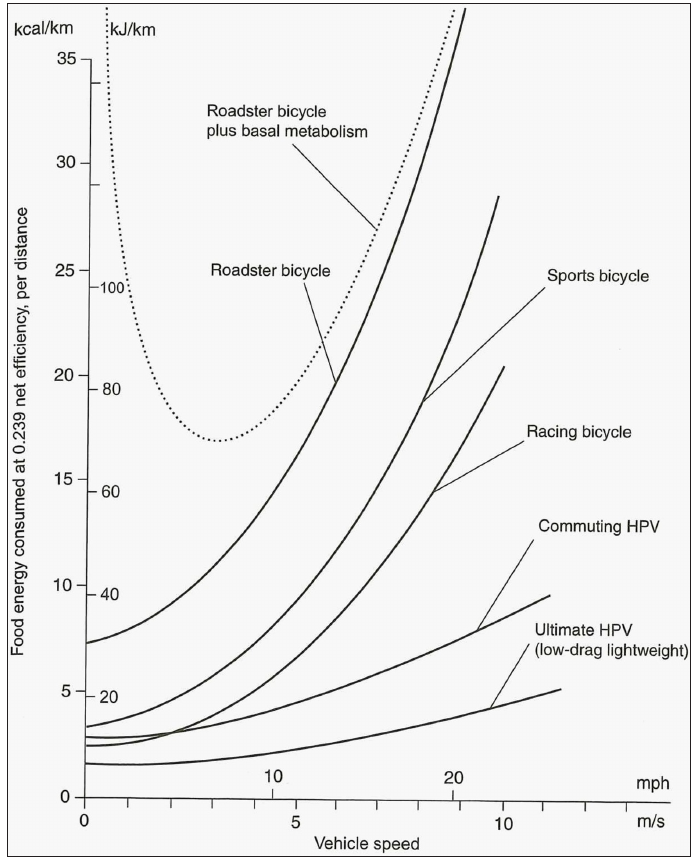
Figure 5: Speed to food energy